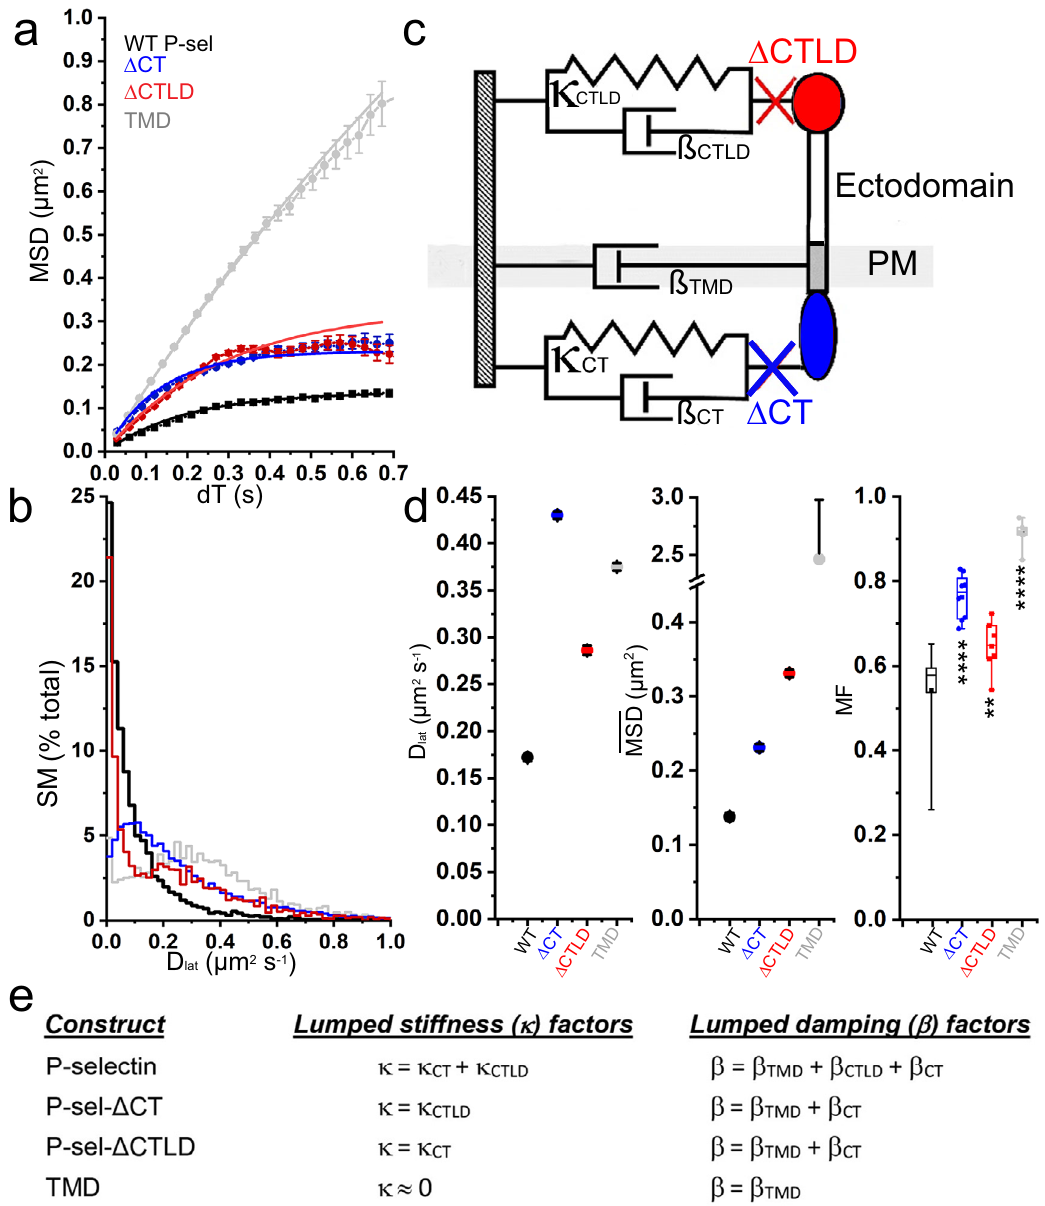
Fig. 3 CT and CTLD independently shape P-selectin mobility at steady-state. a Plots of MSD vs dT for Δ CTLD (Blue; 2621 SMs, n = 6 cells), Δ CT (Red; 6080 SMs, n = 8 cells) and TMD (Light Gray; 1687 SMs, n = 6 cells) under steady-state conditions. For comparison, data for full-length P-selectin (from Fig. 1e) is shown in Black. Solid lines are least-squares fi ts by global fi tting (see main text and panels c , e ). b D lat distribution for each molecule, color-coded as in a . c Mechanical model showing how intracellular, transmembrane and extracellular regions of P-selectin may act as independent Kelvin – Voigt elements which in different combinations give the MSD vs dT fi ts shown in a . CT (red) and CTLD (blue) regions contribute visco-elasticity while the TMD (gray), acts only as a viscous element. Red and blue crosses indicate how Δ CT and Δ CTLD mutations change the mechanical coupling. d D lat ( fi tted values ±95% con fi dence intervals), limiting amplitude (MSD) ( fi tted values ±95% con fi dence intervals), and MF (Box and Whiskers as de fi ned in Fig. 1) for the different protein constructs (as indicated). Results of one-way ANOVA, multiple comparisons, Dunnett tests indicated as: “ **** ” P < 0.0001; “ ** ” P = 0.008, e Shows how the Kelvin – Voigt elements (shown in c ) combine in different ways to give the lumped stiffness, κ and damping factor, β used for global fi tting (shown in panel a ) to the WT and truncation mutant isotype mouse IgG (IgG-Cy3B) using conditions that gave ~1:1 pausing . To gain a better understanding of the physical factors that labeling stoichiometry (see Methods and Supplementary Fig. 4). might manifest as springs and dashpots in the model, thereby AK6 is thought to bind within the CR region of P-selectin ’ s ecto- shaping the mobility of full-length P-selectin, we used the bright domain and was chosen because it does not interfere with P-selectin and photostable fl uorophore, Cy3B, to perform high-precision SM function 28 or the internalization and intracellular traf fi cking of the molecule 12 . Binding speci fi city in live cells was con fi rmed using localization over extended time periods. The P-selectin ectodomain IgG-Cy3B as a negative control (Supplementary Figs. 4h-k and 5a). was labeled using the anti-P-selectin antibody, AK6, covalently- SM tracking of AK6-Cy3B bound to P-selectin gave MSD vs dT conjugated to Cy3B (AK6-Cy3B), and as control Cy3B labeled